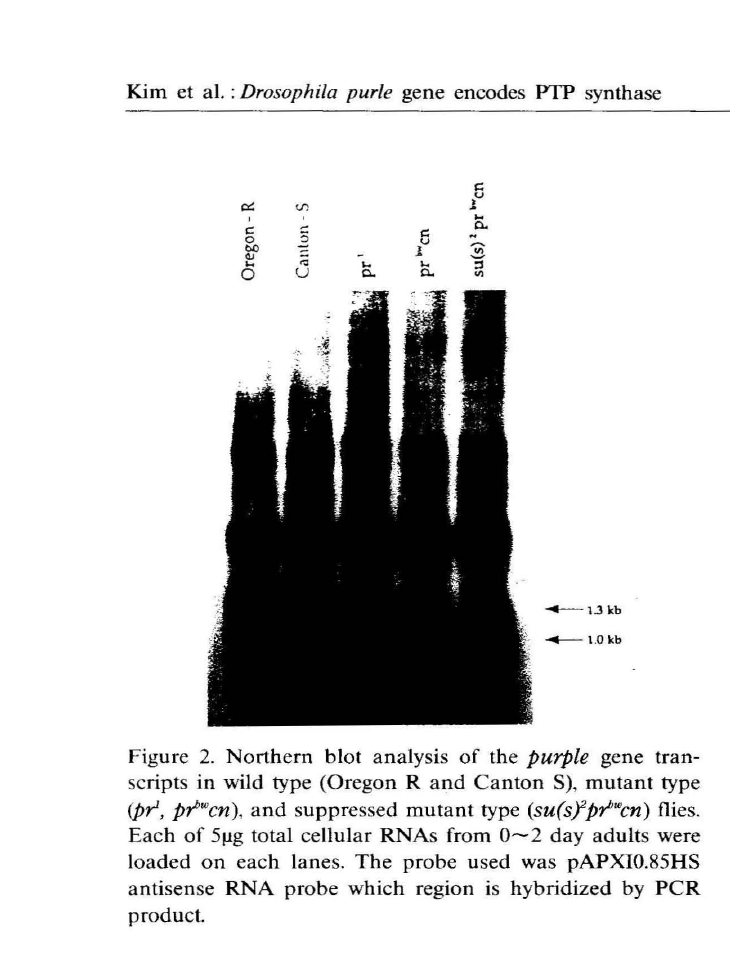
Figure 2. Northern blot analysis of the purple gene tran scripts in wild type (Oregon R and Canton S), mutant type (j)'r, pybwcn), and suppressed mutant type (su(sypybwcn) flies. Each of 5flg total cellular RNAs from 0-2 day adults were loaded on each lanes. The probe used was pAPXIO.85HS antisense RNA probe which region is hybridized by PCR